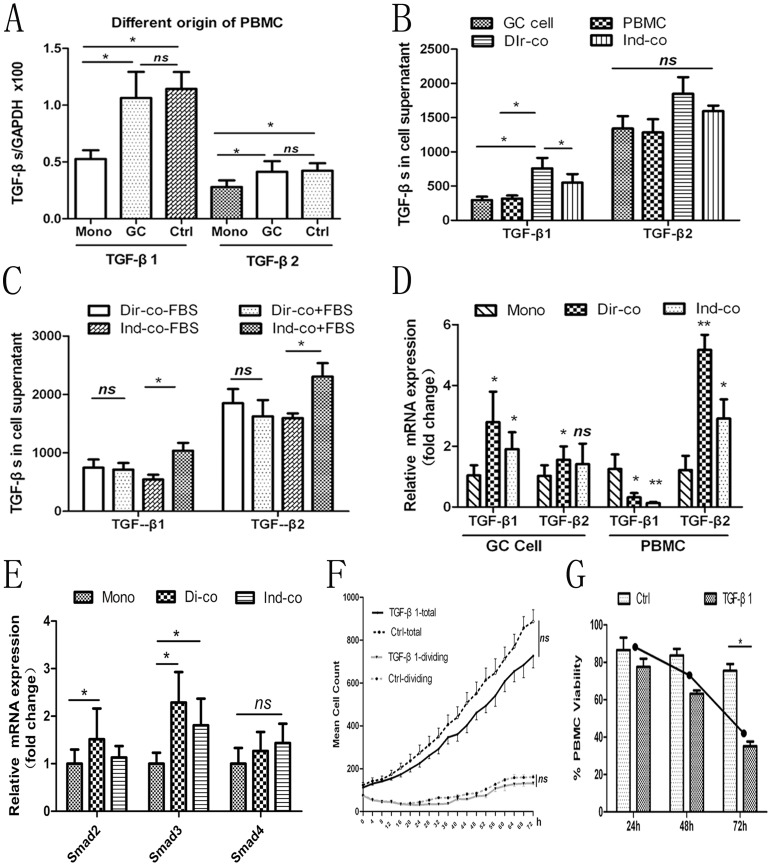
Changes in TGF-β1 and TGF-β2 expression in a coculture model.(A) TGF-β1 and TGF-β2 mRNA levels in GC cells after direct cocultures were increased compared to monoculture, but there were no significant differences in TGF-β1 and TGF-β2 mRNA levels in GC cells, irrespective of the origin of the PBMCs (GC patients or controls). (B) TGF-β1concentrations in the cell supernatant of cocultures were significantly increased compared to those in PBMCs or GCs cultured alone in a FBS-free environment (P<0.05). Its levels in the direct coculture group were significantly higher than those in the indirect group (P = 0.029). TGF-β2 levels were also increased in direct cocultures, but the differences after cocultures were not significant. (C) Cytokine production levels were significantly increased in indirect coculture groups after the addition of FBS (P<0.05), but no obvious change was detected in direct coculture ones. The experiment was conducted twice. All data are shown as means ± SD of triplicates. (D) Origin of cytokines. In GC cells, TGF-β1 mRNA levels were increased approximately 3-fold in the direct coculture and increased 2-fold in the indirect one compared to monocultures; TGF-β2 mRNA levels were significantly increased after direct coculture but not statistically changed after indirect one. In PBMCs, TGF-β1 mRNA levels were significantly decreased and TGF-β2 levels were remarkably increased after cocultures. Levels were normalized to GAPDH, and levels in the monoculture group were defined as 1.0. All data are shown as means ± SD. (E) The mRNA levels of Smad2 and Smad3 in GC cells were significantly increased after cocultures (P<0.05), which were higher in the direct coculture than those in the indirect one, but there was no statistic difference in the levels of Smad4. (F) Cell-IQ showed that the addition of exogenous TGF-β1 (25 ng/mL) to GC cells suppressed the growth and division of tumor cells, but with no significant difference. Eight images from different visual field were analyzed for each group. (G) Cell Counting Kit-8 (CCK-8) assay showed that TGF-β1 (25 ng/mL) inhibited the viability of PBMCs significantly at 72 h. The line shows the inhibition ratio of TGF-β1 stimulated cells compared to untreated controls. GC: gastric cancer; PMBC: peripheral blood mononuclear cell; Dir-co: direct coculture; Ind-co: indirect coculture; Mono: monoculture; FBS: foetal bovine serum. ns, not significant; *, P<0.05; **, P<0.05.